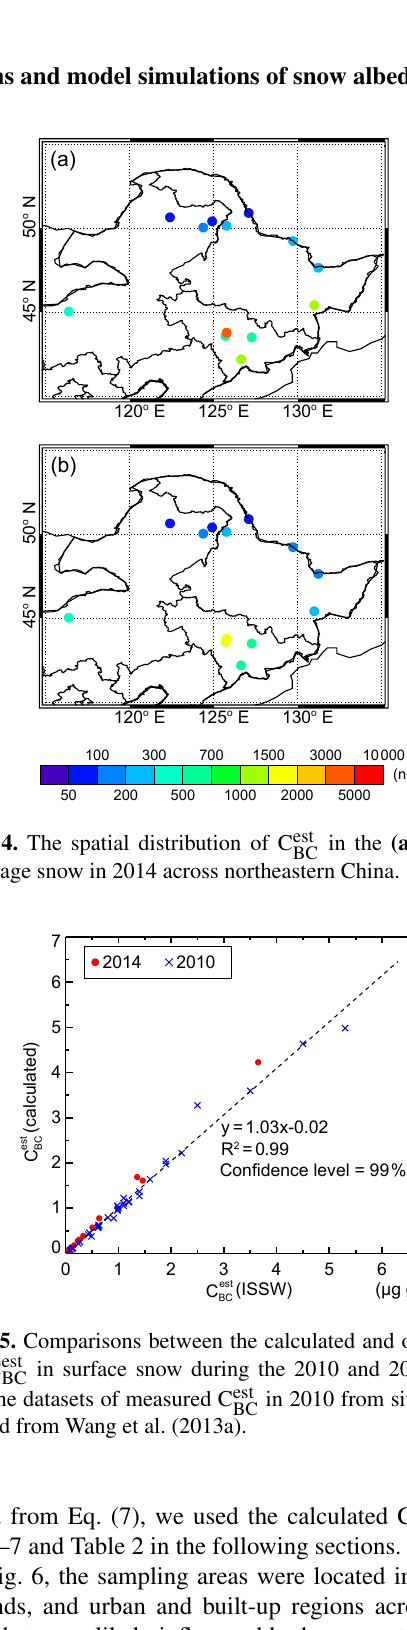
Figure 5. Comparisons between the calculated and optically mea- sured C est in surface snow during the 2010 and 2014 snow sur- BC veys. The datasets of measured C est in 2010 from sites 3–40 were BC reprinted from Wang et al.